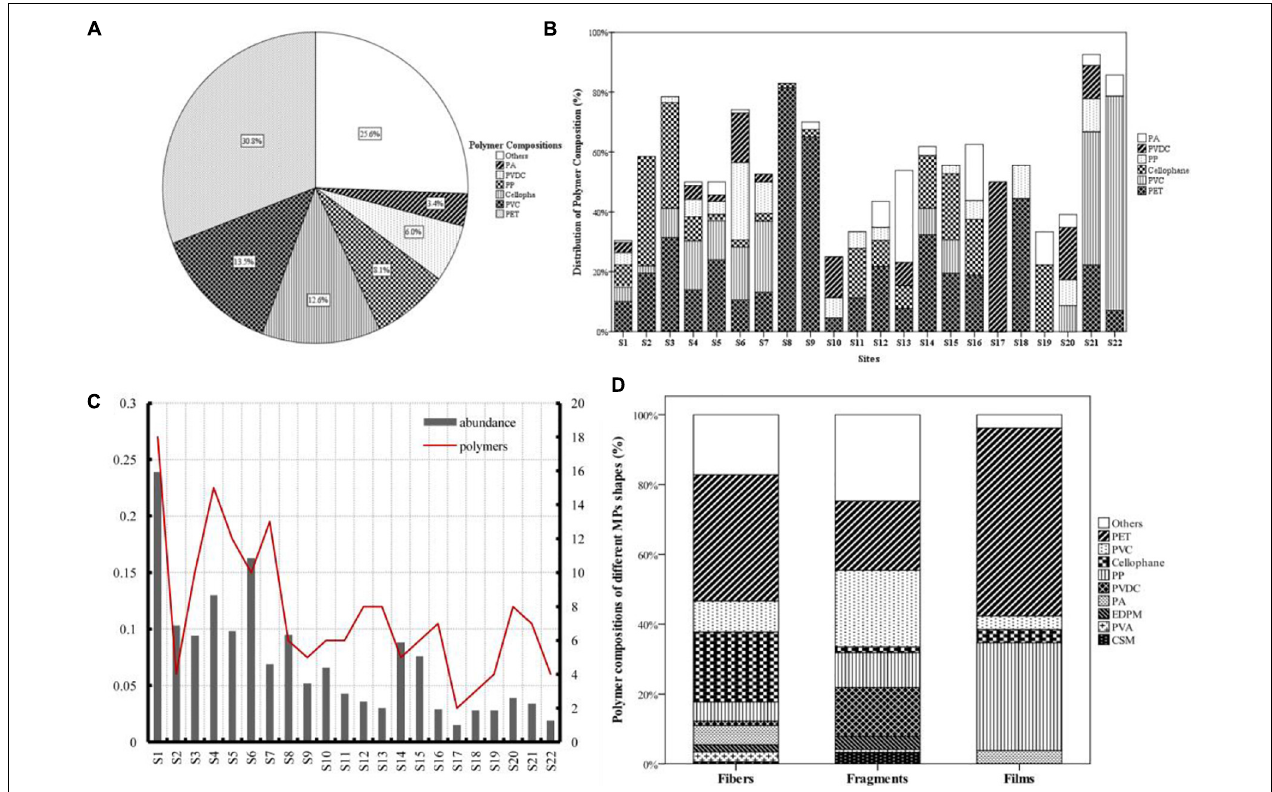
FIGURE 4 | (A,B) The proportions of six major polymer of surface MPs around the southwestern SCS. S20, S21, and S22 were located around Zhongsha Island and Xisha Islands. (C) MPs abundances and total polymer types at all the sampling sites. (D) The proportions of different shapes of MPs polymers: fibers, fragments, and